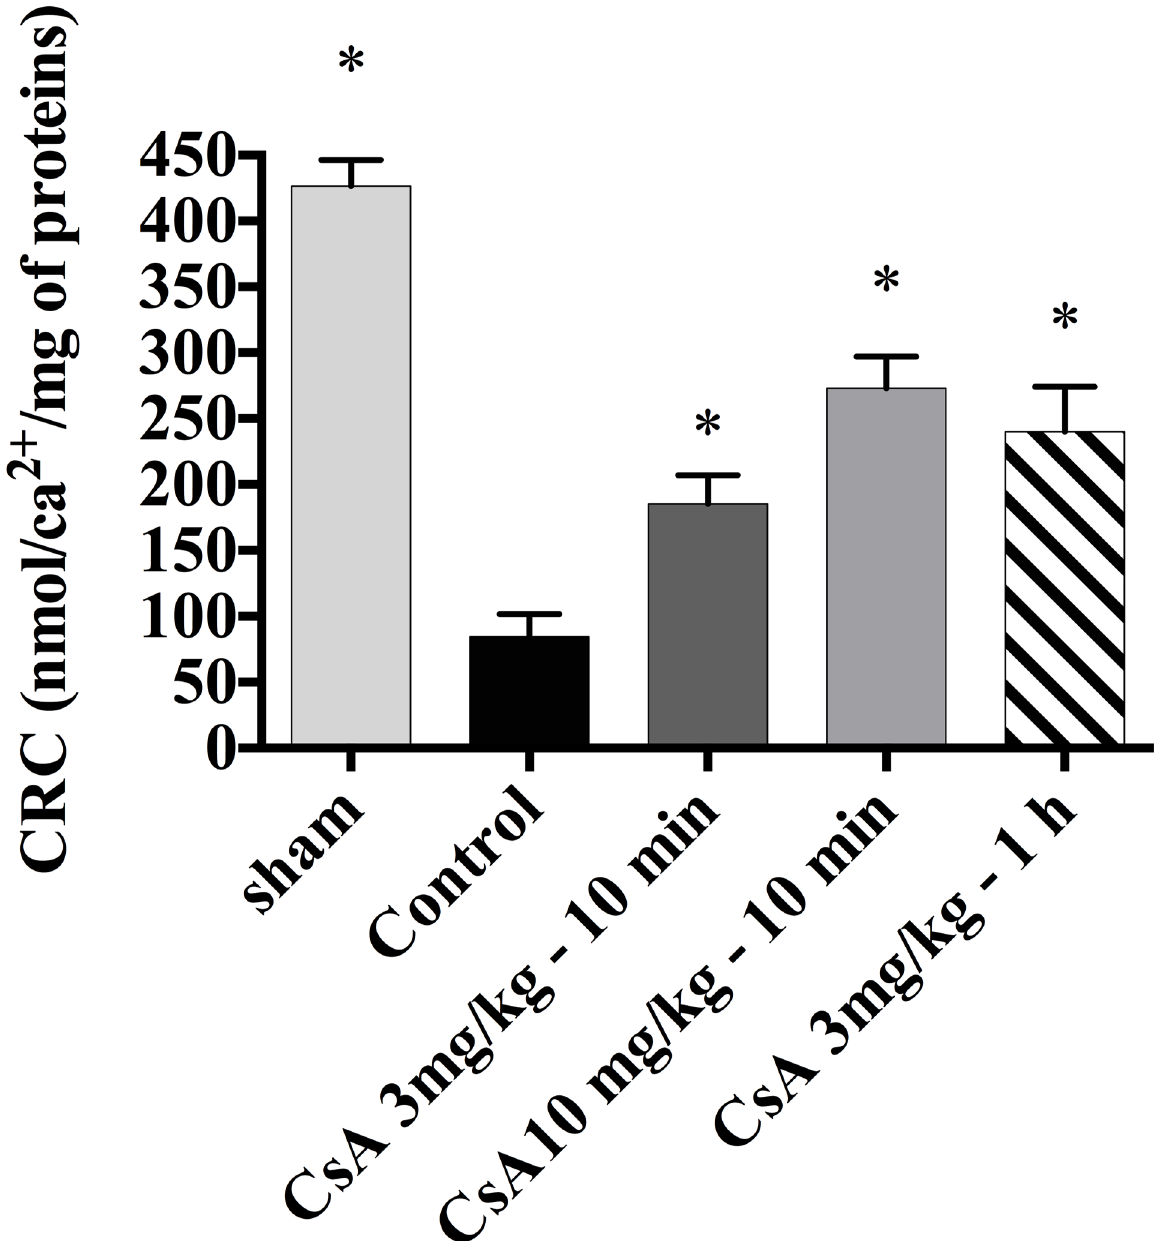
Fig 3. Impact of the dose of CsA on mitochondrial function. (A) Calcium retention capacity (CRC) 24 h after reperfusionas a function of the CsA dose. Mitochondrial PTP openingwas significantly inhibitedin the control versus the sham group. The CRC 24 h after reperfusionwas significantly higherin the CsA 10 mg/kg-10 min group than in the control or CsA 3 mg/kg-10 min groups( * p < 0.05 vs control group).